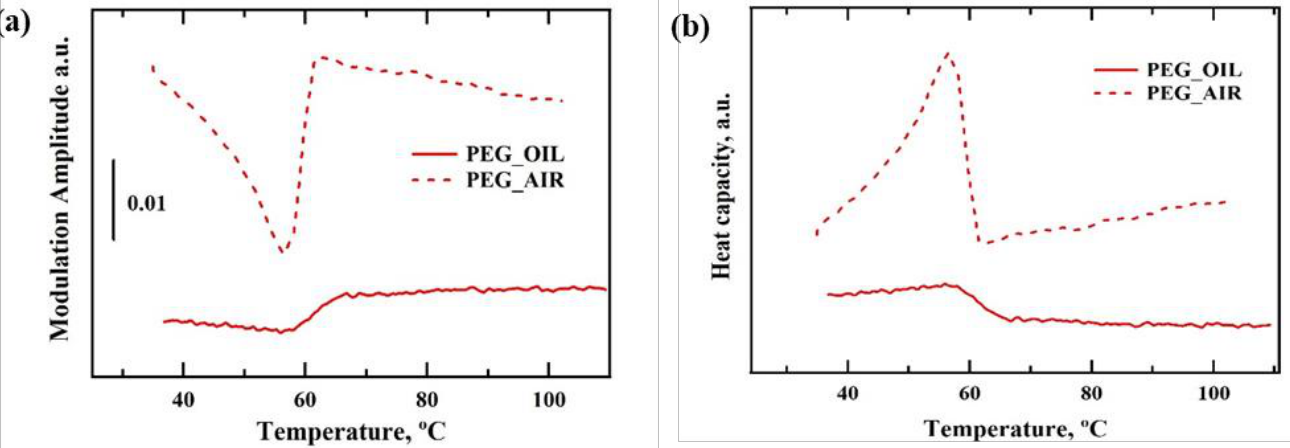
Figure 7. Melting of polyethylene glycol (PEG) recorded in bulk liquid using the thermal nano- analyzer instrument in hybrid AC/DC mode. Recorded heat modulation AC amplitude vs. sample temperature ( a ). Specific Heat changes estimated from the recorded profile of modulation AC amplitude ( b ). Dotted lines represent PEG in air, solid lines represent PEG measured immersed in a large volume of liquid oil.